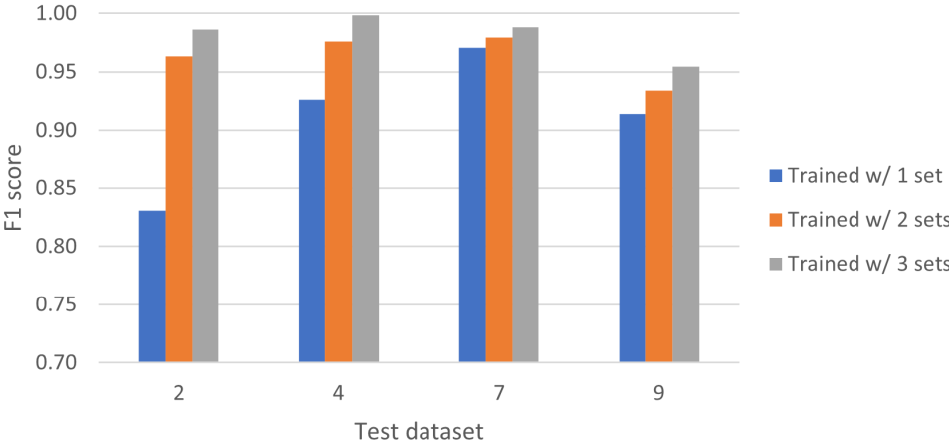
Figure 3. Results per test dataset, using one, two and three sets for training.